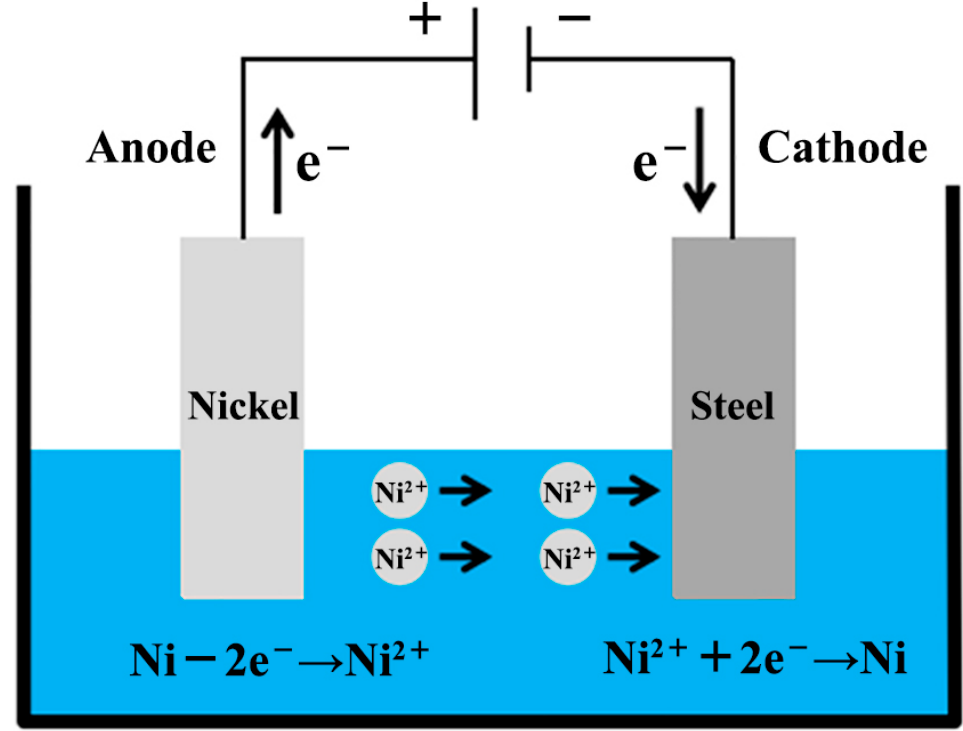
Figure 1. Schematic diagram of the electroplating process for Ni coating on the steel surface